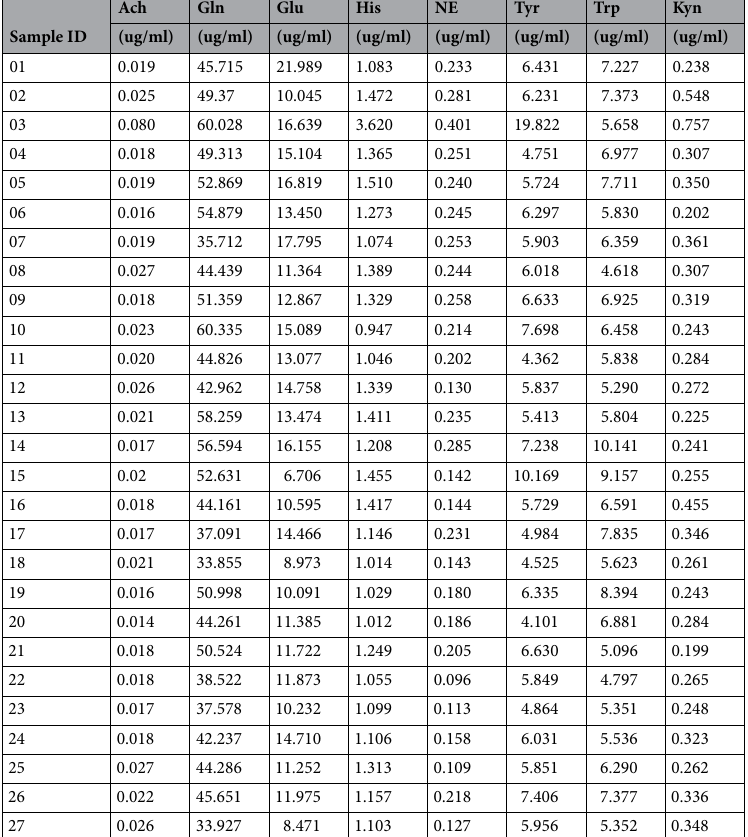
Table 1. Concentration of multiple neurotransmitters in human follicular fluid. Ach acetylcholine chloride, Gln glutamine, Glu glutamate, His l-Histidine, NE norepinephrine, Tyr: tyrosine, Trp tryptophan, Kyn